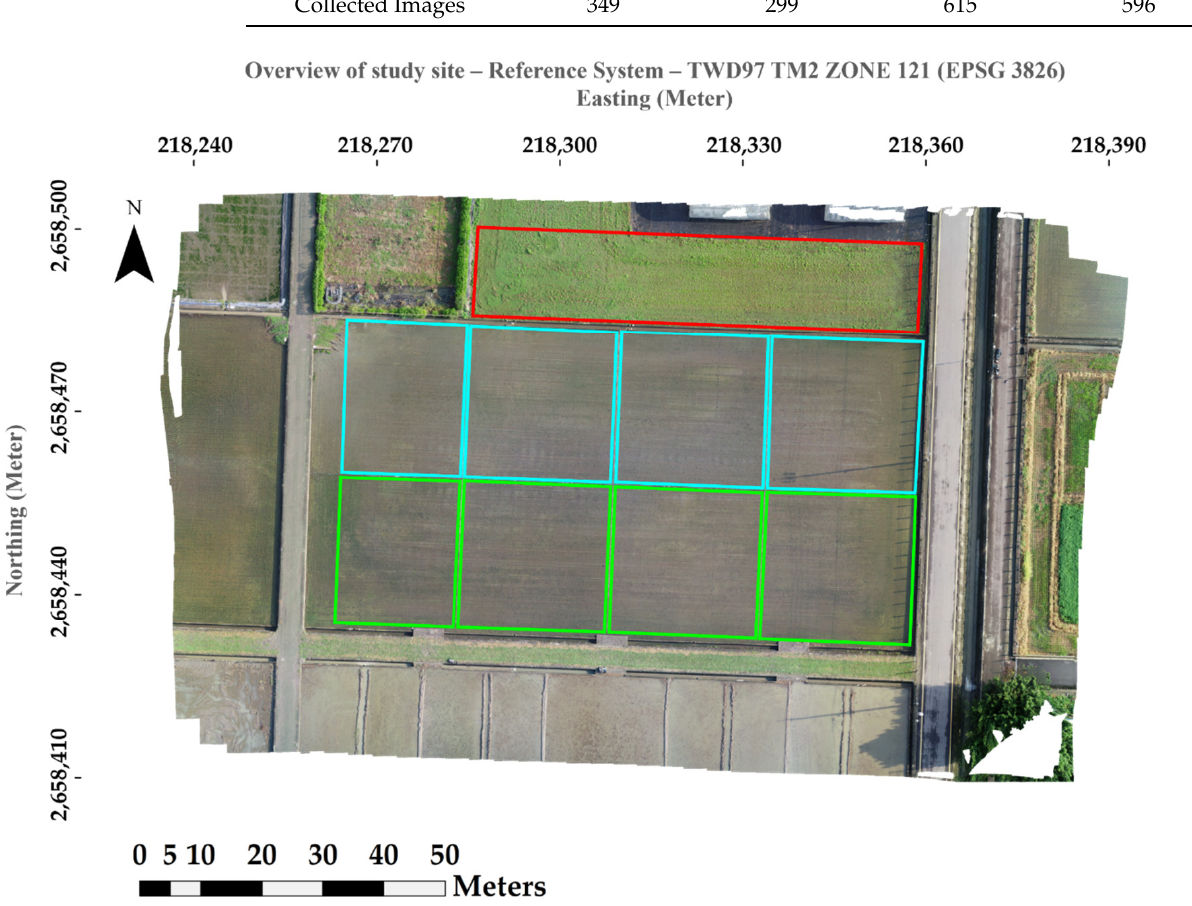
Figure 2. An overview of UAV image acquired on 7 August 2018. Reference system is TWD97 TM2 zone 121, EPSG: 3826.